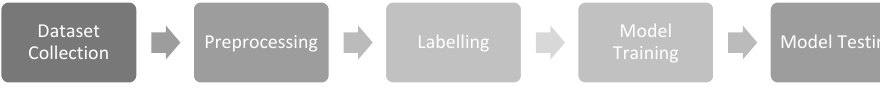
Figure 2. Machine Learning Methods for Crack Detection.